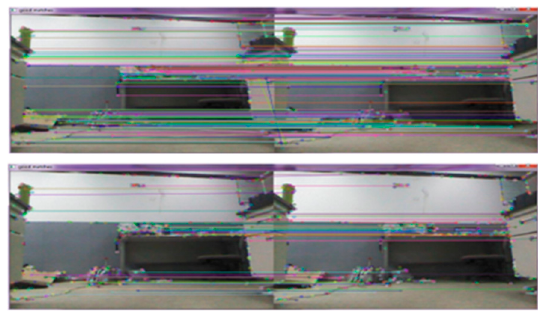
Figure 5. Comparison of matching results (example 1). Table 1. Comparison of matching result (example 1).